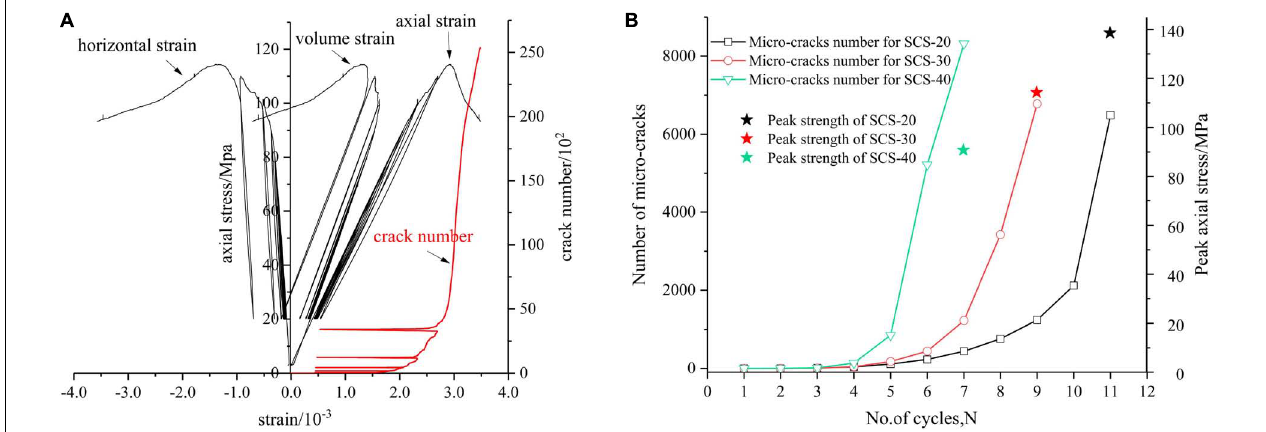
FIGURE 7 | (A) Influence of axial stress on the axial strain, horizontal strain, volume strain, and crack number of specimen SCS-30 under triaxial cyclic loading. (B) Numbers of micro-cracks with the number of cycles and peak strength.